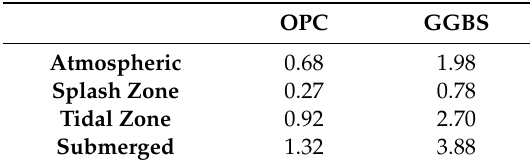
Table 7. Characteristic values of the environment factor k e , cl